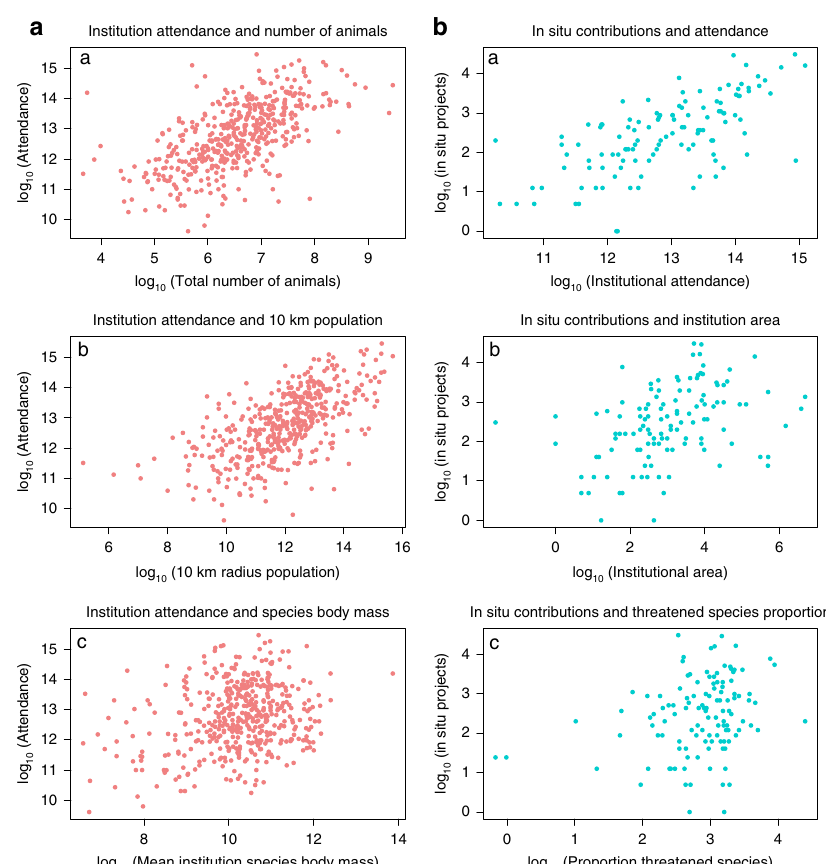
Fig. 3 Bivariate relationships between institutional attendance, in situ contributions and their strongest predictors. a (left panel, n = 458), log 10 transformed bivariate plots of institutional attendance and total number of animals, 10 km radius population and mean species body mass a – c. b (right panel, n = 119), log 10 transformed bivariate plots of institutional in situ contributions and attendance, institutional area and the proportion of